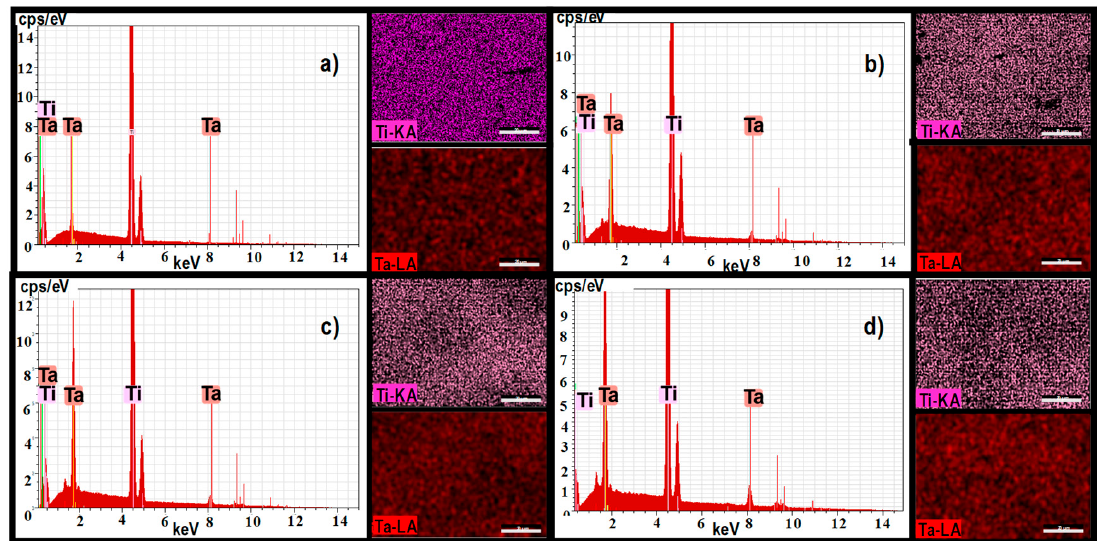
Figure 1. Atoms distribution of Ti and Ta in the studied alloys: ( a ) Ti5Ta, ( b ) Ti15Ta, ( c ) Ti25Ta, and ( d ) Ti30Ta.